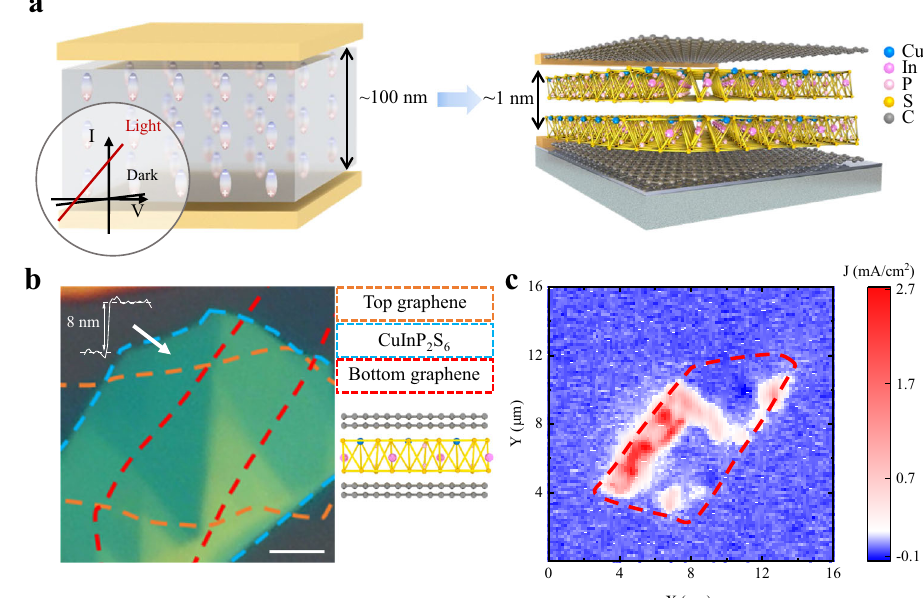
Fig. 1 Bulk photovoltaic effect in 2D ferroelectric CIPS. a (Left panel) The schematic structure of 3D BPVE device with fi lm thickness at the order of around 100 nm. Inset shows the characteristic I – V curve of the bulk photovoltaic effect in 3D ferroelectrics. The black and red lines represent the I – V curves at the dark conditions and bright conditions, respectively. (Right panel) The schematic structure of 2D BPVE device. The thickness of 2D ferroelectrics can be as thin as 1 nm. b , c The optical image and corresponding short-circuit photocurrent density mapping of the 2D BPVE device. The region of top graphene, ultrathin CIPS, and bottom graphene are marked with orange, blue, and red dashed lines, respectively. The scale bar in b is 3 μ